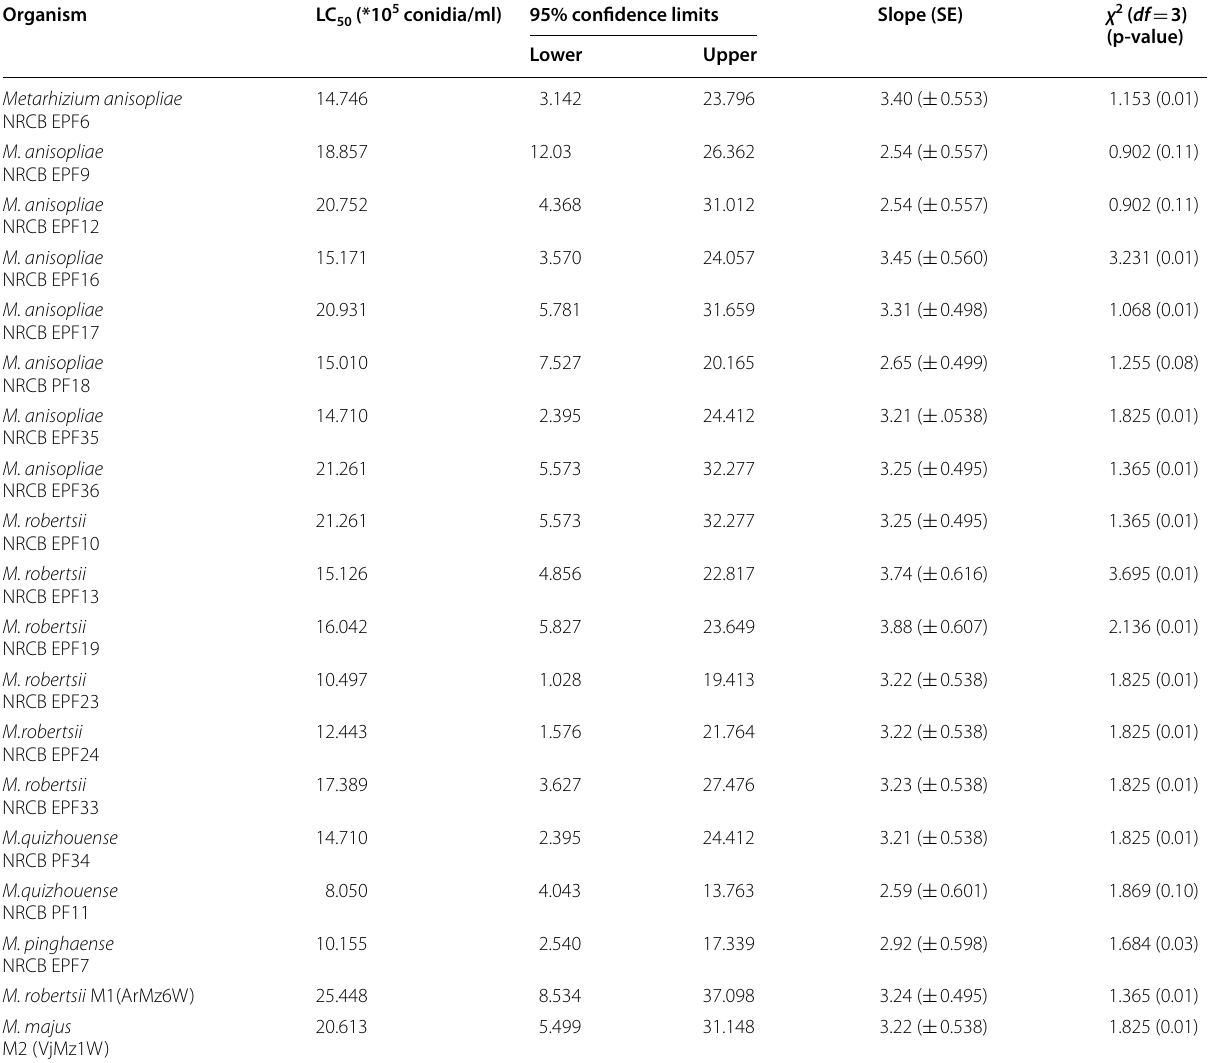
Table 3 Probit analysis of concentration-mortality response at 15 days post inoculation of Metarhizium spp. against Odoiporus longicollis